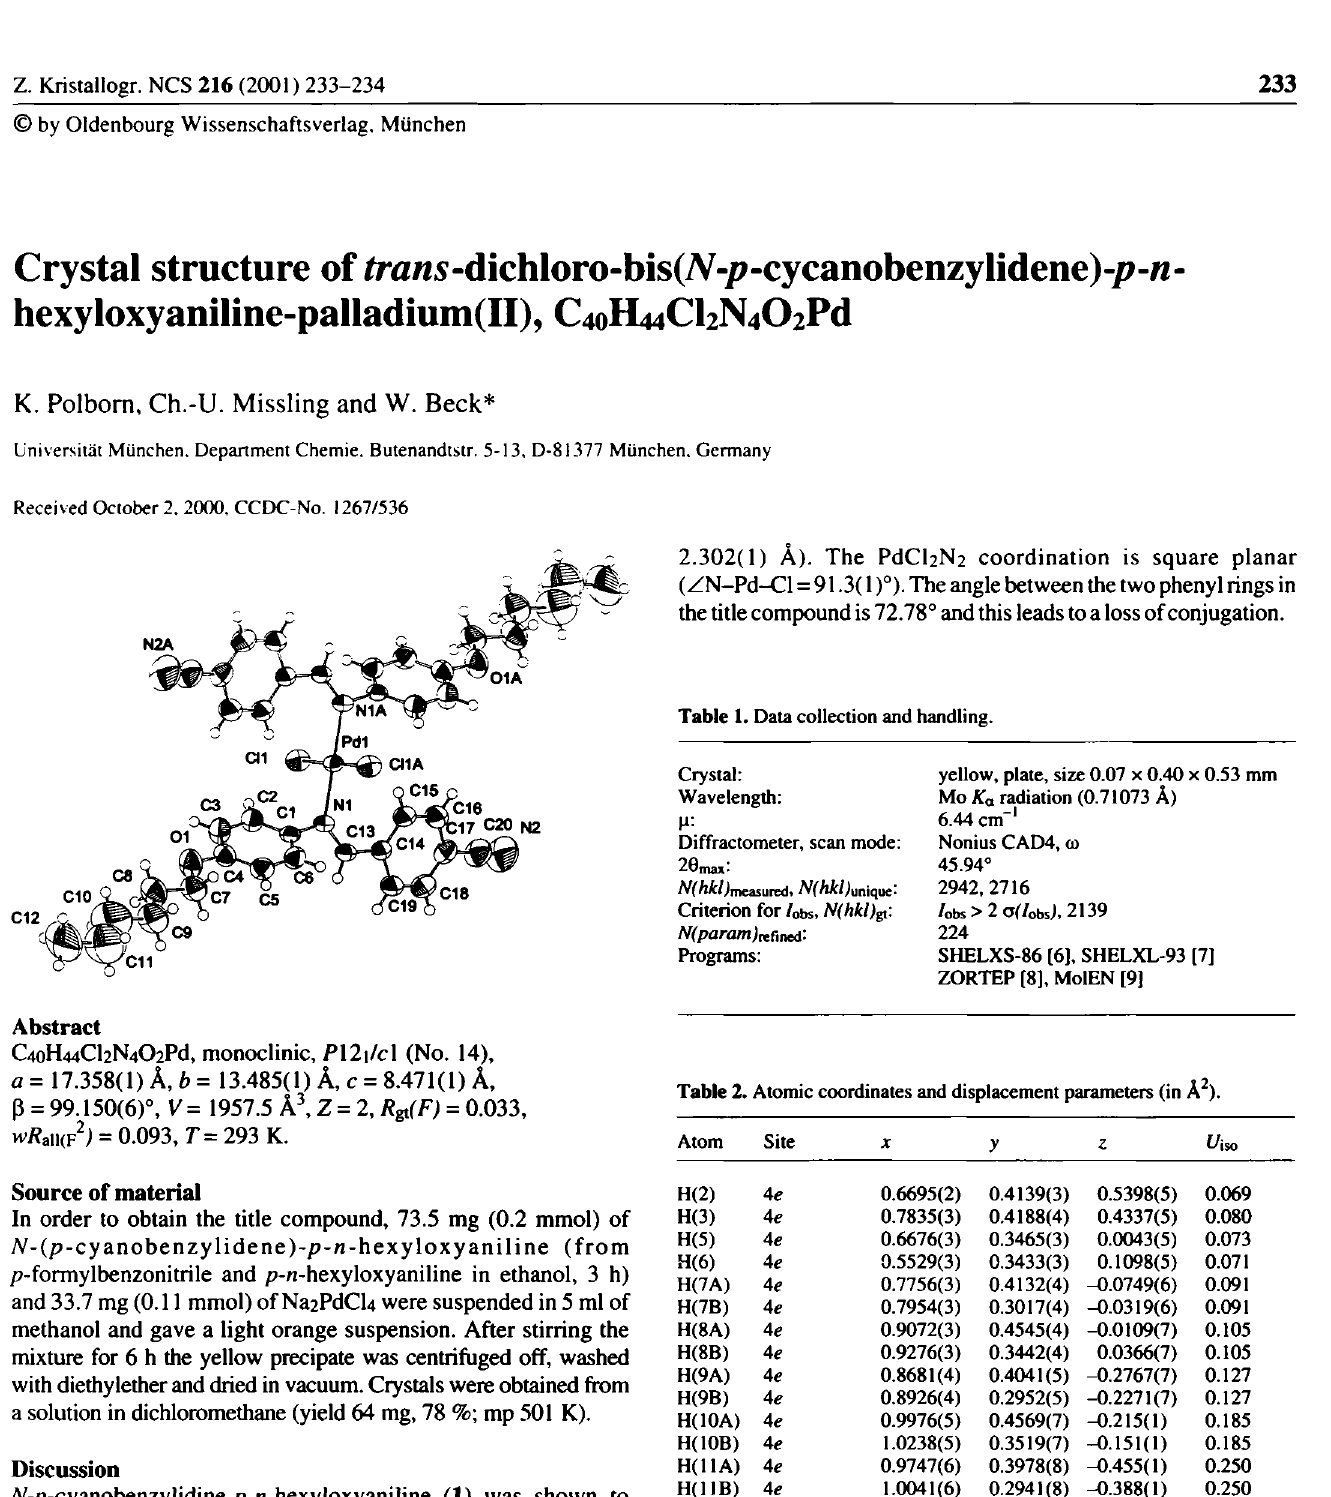
Table 2. Atomic coordinates and displacement parameters (in A 2